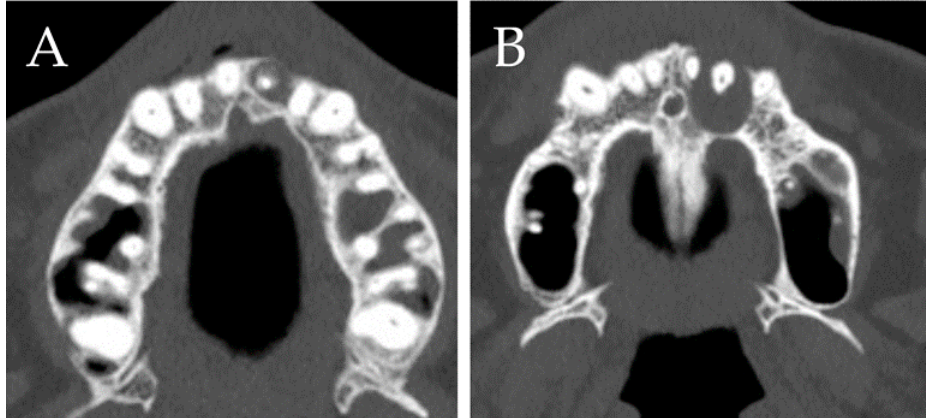
Figure 2. Representative perilesional sclerotic images in axial view of CT: ( A ) positive perilesional sclerotic sign; ( B ) negative perilesional sclerotic sign.